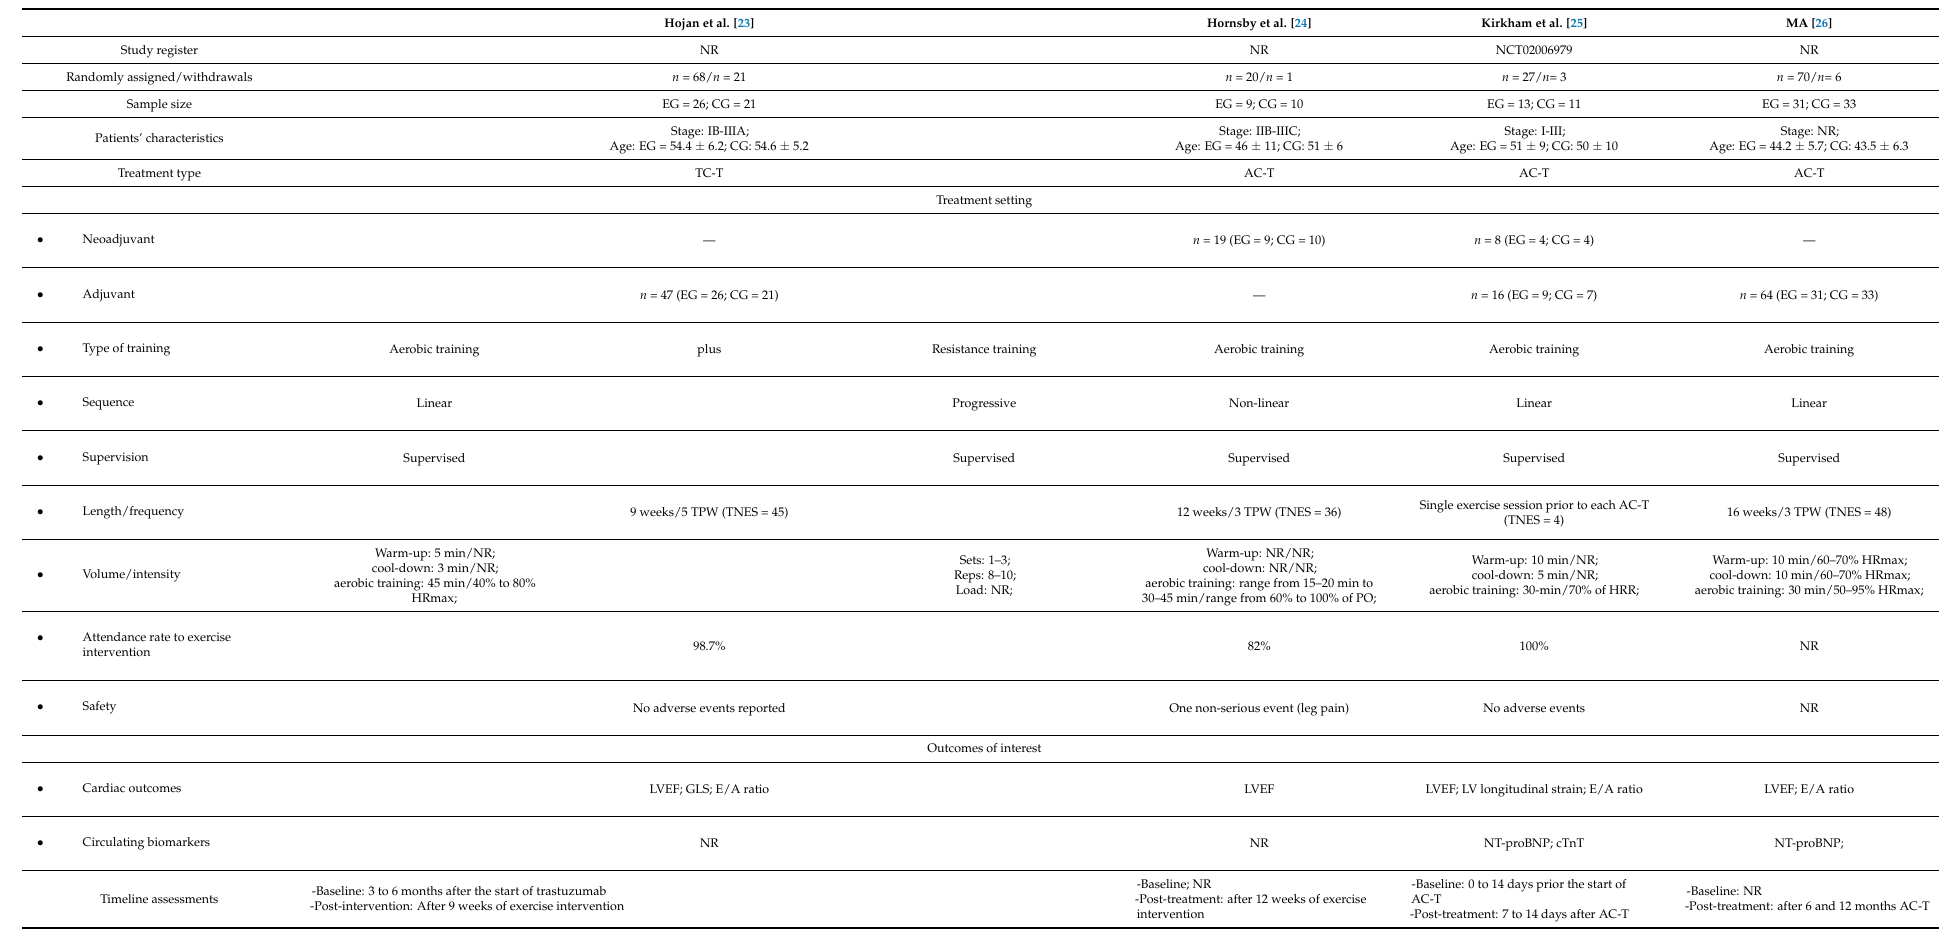
Table 1. Characteristics of the included